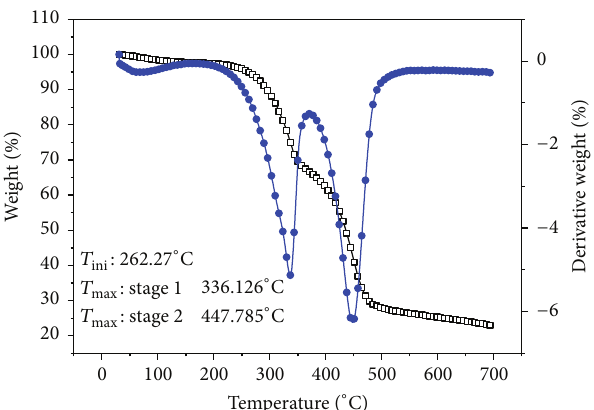
Figure 2: TGA and DTG curves of char-forming agent